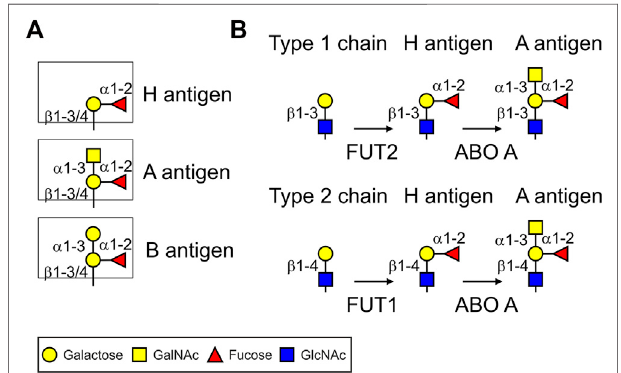
FIGURE 1 | Cartoon illustration of ABH(O) blood group antigens and biosynthetic pathways. (A) ABH blood group carbohydrate structures. (B) Biosynthetic steps to produce blood group A type 1 and 2 antigens common to N- and O-glycans. FUT1/FUT2: α 1,2-fucosyltransferases; ABO A: α 1,3-GalNAc-transferase (A enzyme). For the biosynthesis of blood group B structures the ABO A enzyme is replaced by the α 1,3-galactosyltransferase (ABO B